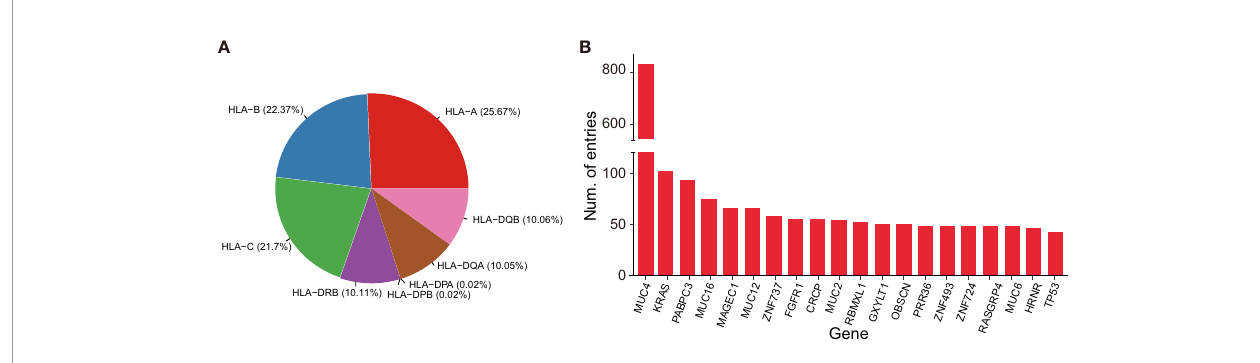
FIGURE 2 | Statistics of experimentally validated data in NEPdb. (A) The distribution of HLA alleles. (B) Top 20 genes with the most validated neoepitope and non- immunogenic peptides in NEPdb.